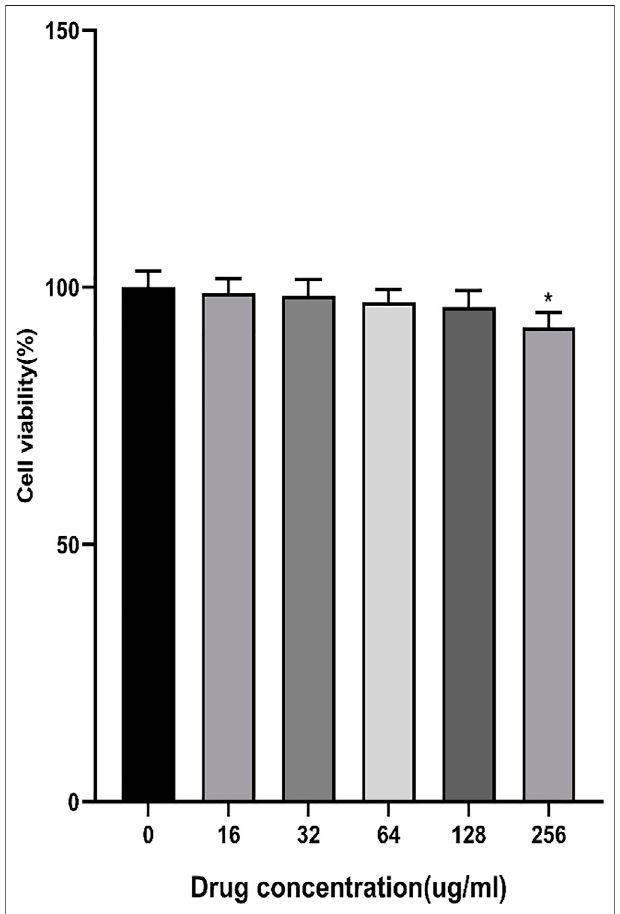
FIGURE 1 | Effects of different concentrations of AEE (16~256 μ M) on Caco-2 cell viability. Values are presented as the means ± SD where applicable ( n = 6). * p < 0.05 than the control